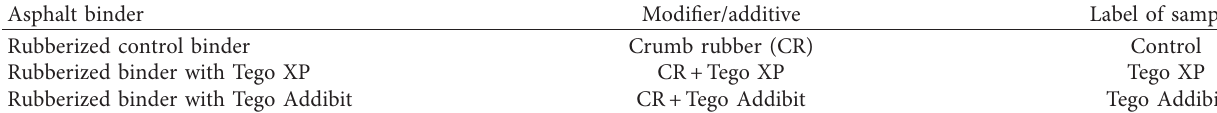
Table 4: Asphalt binder labels utilized herein.